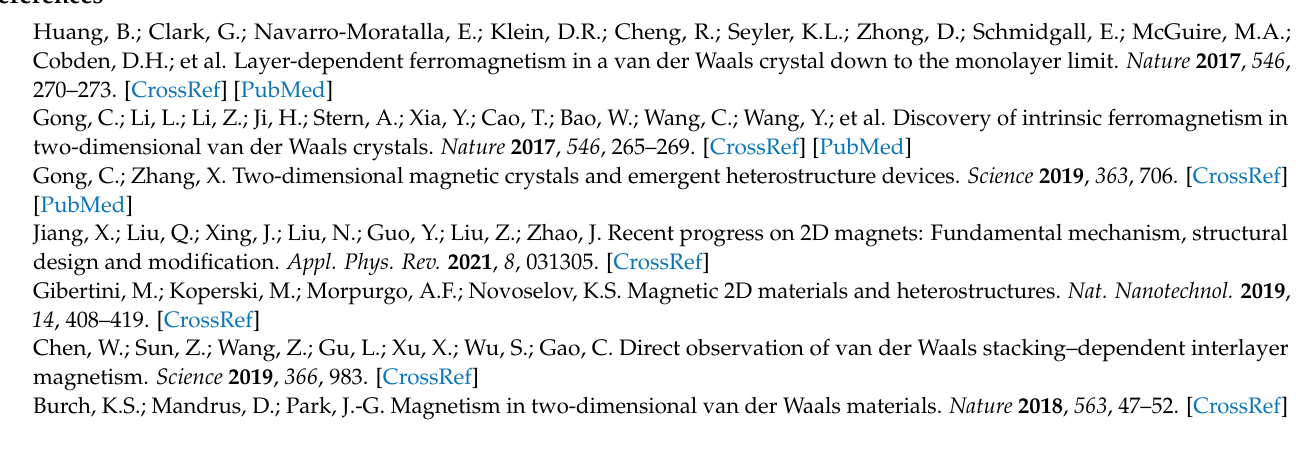
Figure S2: (a,b) Optical microscopy images of the CrBr 3 flakes exposed to a stronger light irradiation in air for 0 min and 4 min,